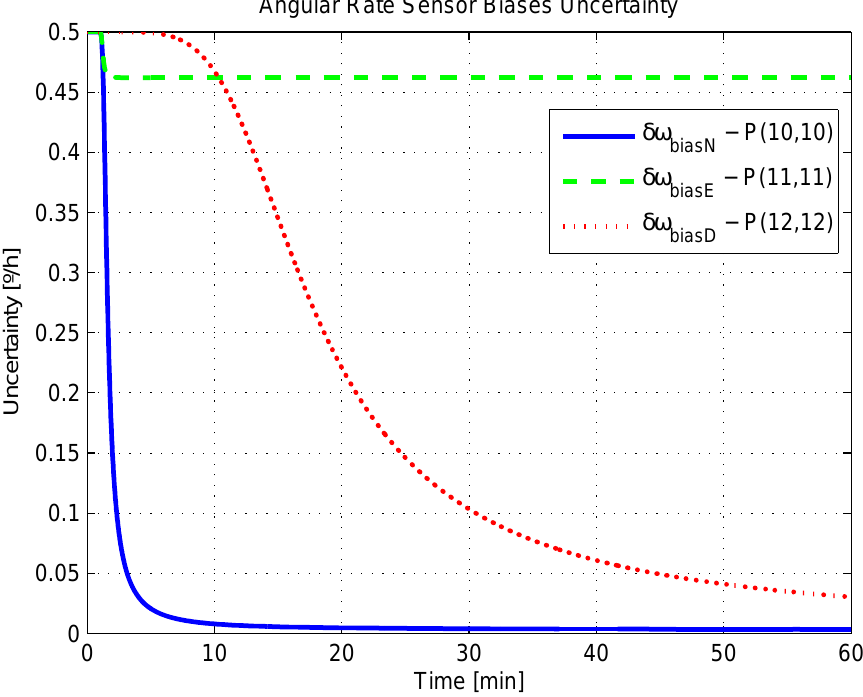
Figure 5. Angular rate sensor biases uncertainty in the simulated test.